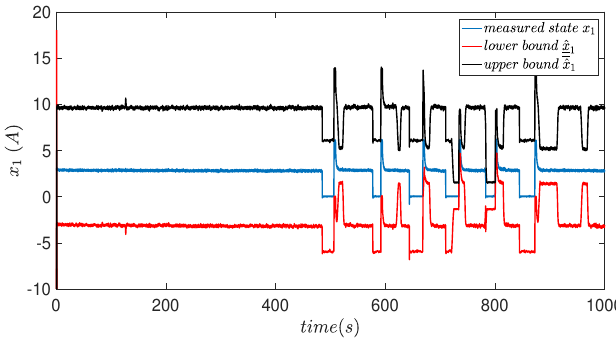
Figure 8. Measurement of armature current x 1 ( k ) and estimation of interval